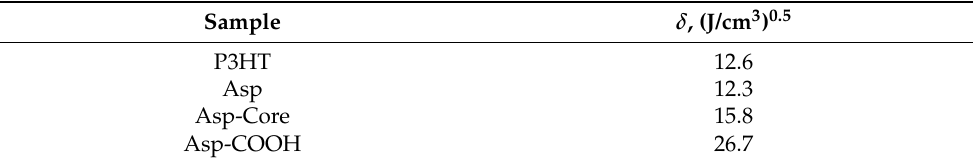
Table 1. Estimated solubility parameter δ